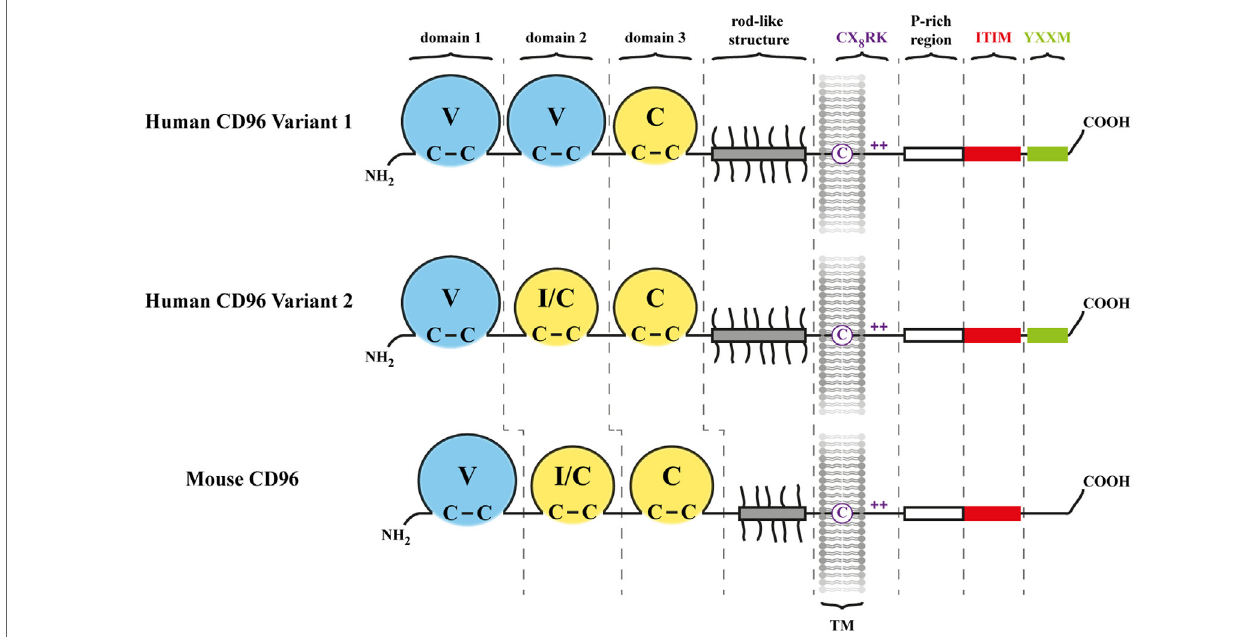
FiGURe 1 | Architecture of CD96. Shown are the two human CD96 (hCD96) isoforms (variant 1 and variant 2) along with mouse CD96 (mCD96). Three Ig-like domains comprise the N-terminal (NH 2 ) part of CD96 in mouse and hCD96 where V indicates a V-like domain and C indicates a C-like domain. The second domain is predicted to fold as an I-like or C-like domain in hCD96 variant 2 and mCD96. The proline/serine/threonine-rich region (gray bar) contains many potential O-linked sugar modification sites (short protrusions) and may adopt a rod-like shape. The transmembrane (TM) and cytoplasmic domain harbors motifs of potential importance for signaling triggered by CD96 as described in the text and in more detail in Figure 3 . The C denotes a cysteine residing in the TM region, and the + indicates positively charged amino acid